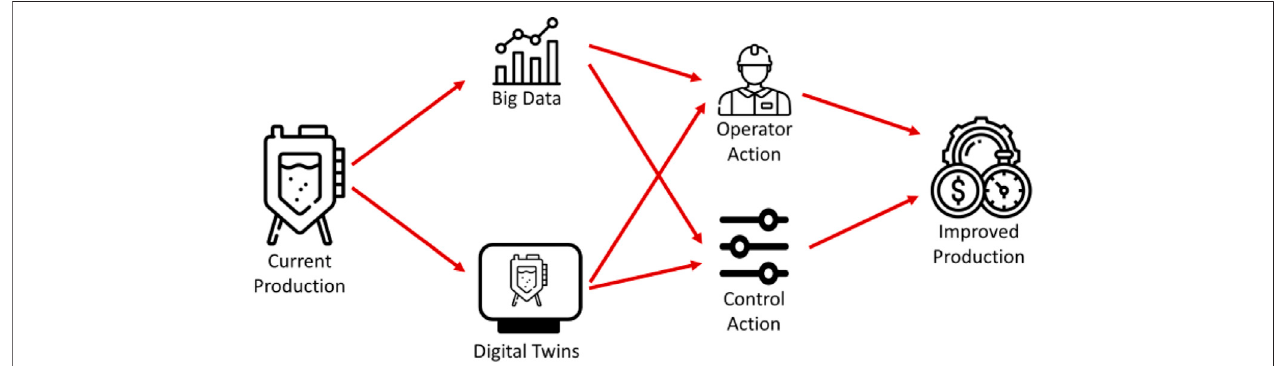
FIGURE 1 | The role of Big Data and Digital Twins in improving production ef fi ciencies.